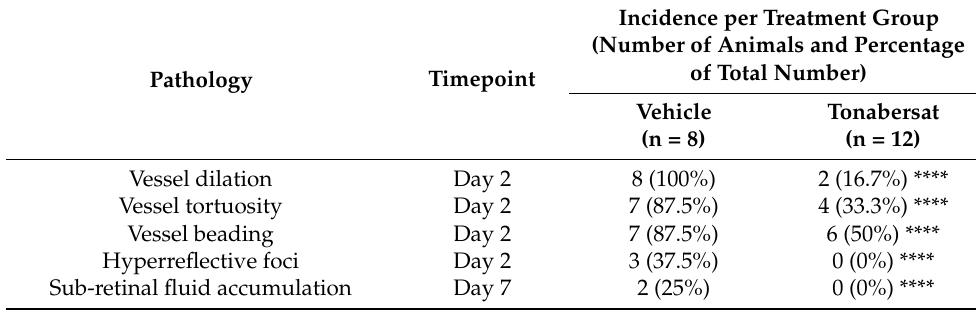
Table 1. Incidence of vascular pathologies assessed from fundus and optical coherence tomography (OCT) images.